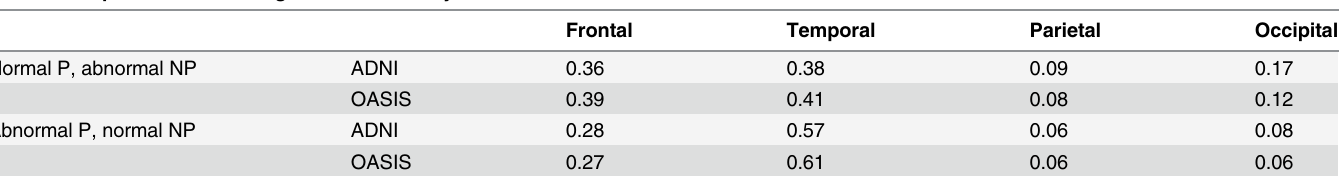
Table 3. Proportions of differing classifications by